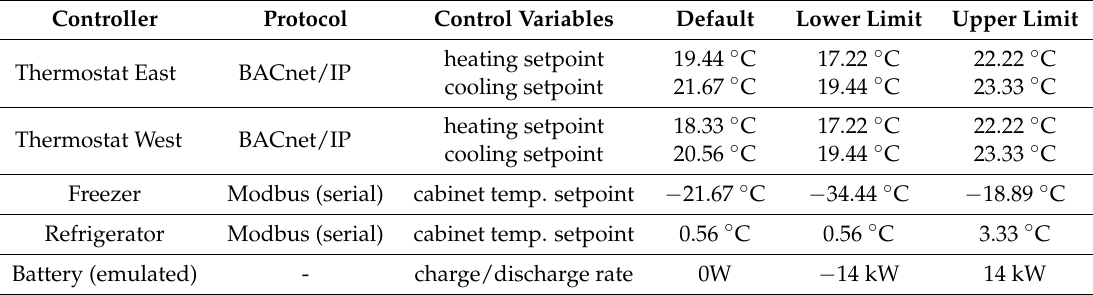
Table 3. List of Controllers and their relevant variables (Outputs of the optimization